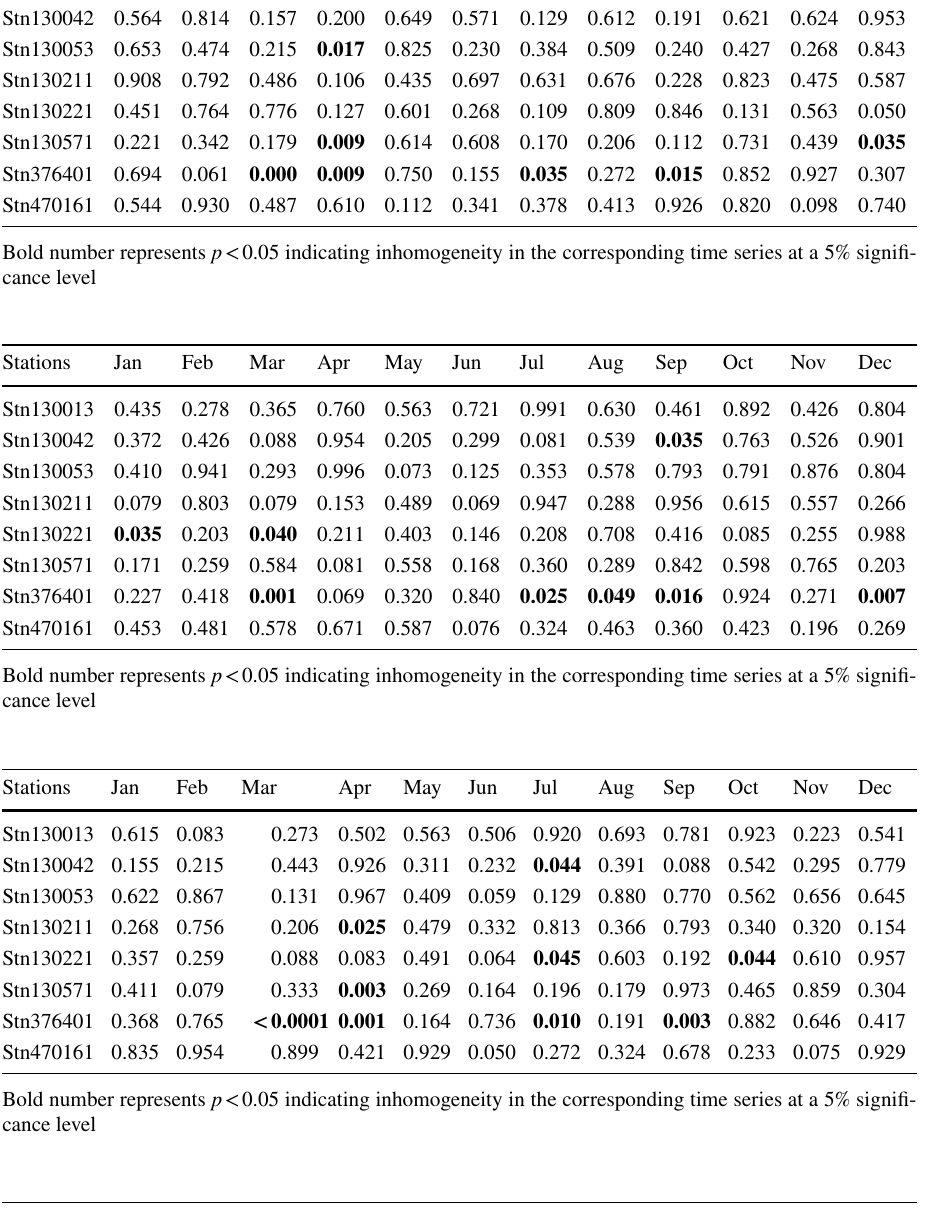
Table 2 The p values obtained from Pettitt test for each calendar month and station